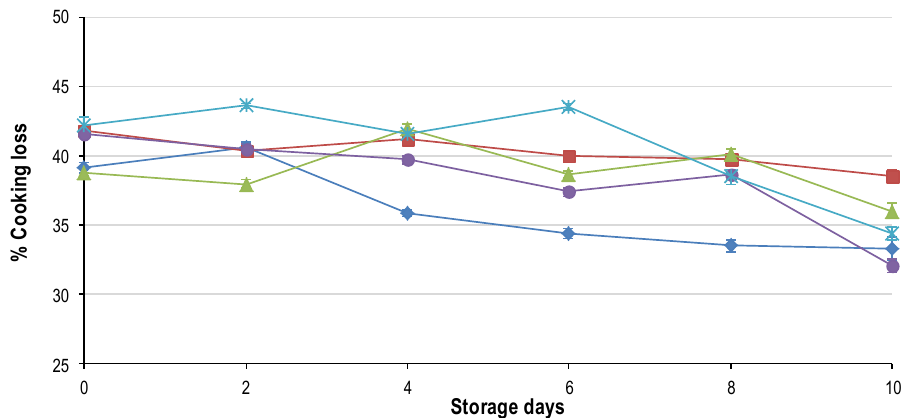
Figure 2. Average cooking loss (±std. error) for the five characteristic freezing rates: FR_1h ( ); FR_2h ( ); FR_4h ( ); FR_8h ( ) and FR_24h ( ) over the 10-day shelf-life trial at ±4 °C.